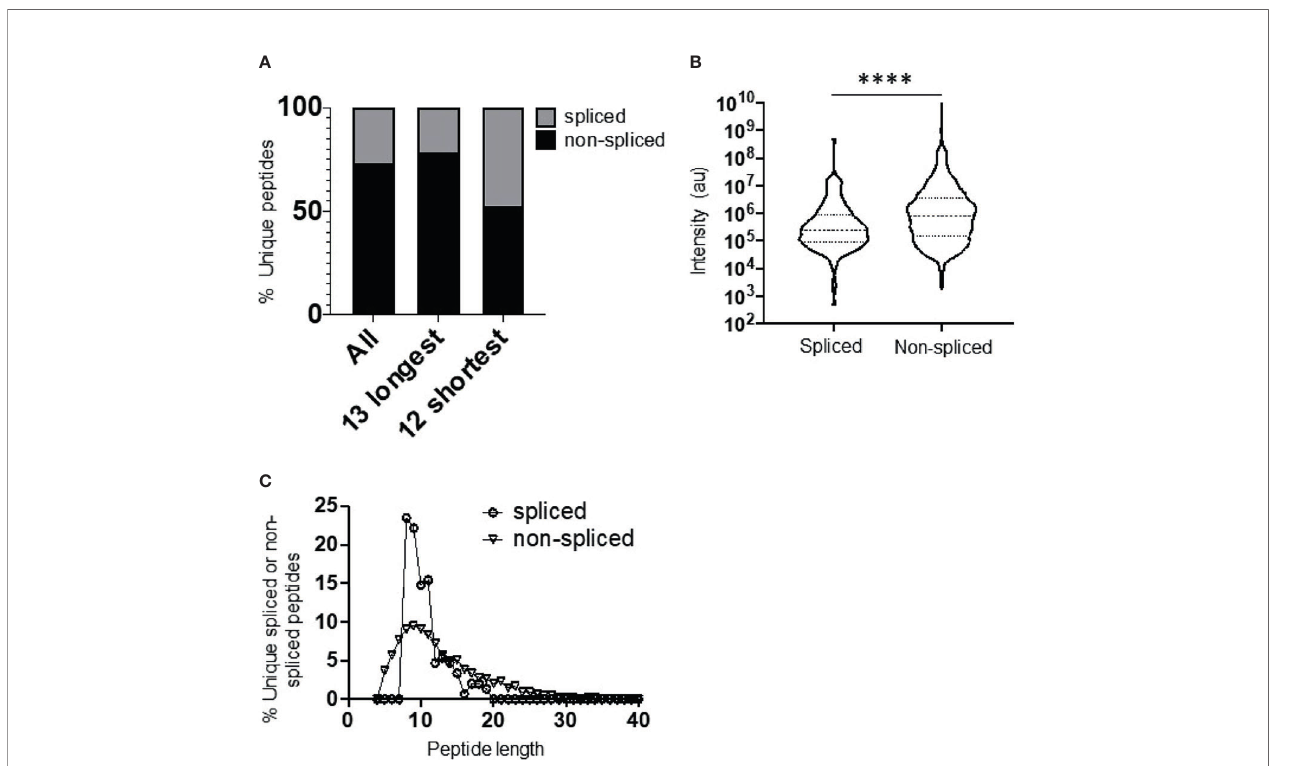
FIGURE 1 | Diversity, abundance, and peptide length distribution of proteasome-derived spliced and non-spliced peptides. (A) Proportion of unique spliced and non-spliced peptides following a 2 h in vitro digestion of 25 self- and HIV-1-derived polypeptides (Table 1) by the constitutive proteasome. Proportions of spliced and non-spliced peptides within all unique peptides (n = 1,656), unique peptides originating from only the 13 longest polypeptide substrates (n = 1,337) and unique peptides originating from only the 12 shortest polypeptide precursors (n = 319) are shown. (B) Violin plots showing abundance of all unique spliced and non-spliced peptides as measured by LC – MS/MS intensity values. Median and quartile abundance values are indicated. A non-parametric unpaired Mann – Whitney t-test was used to determine whether abundance values differed between groups. ****P < 0.0001. (C) Length distributions of unique spliced (n = 135) and non-spliced (n = 900) peptides generated from within polypeptide substrates following a 2 h proteasomal digest.